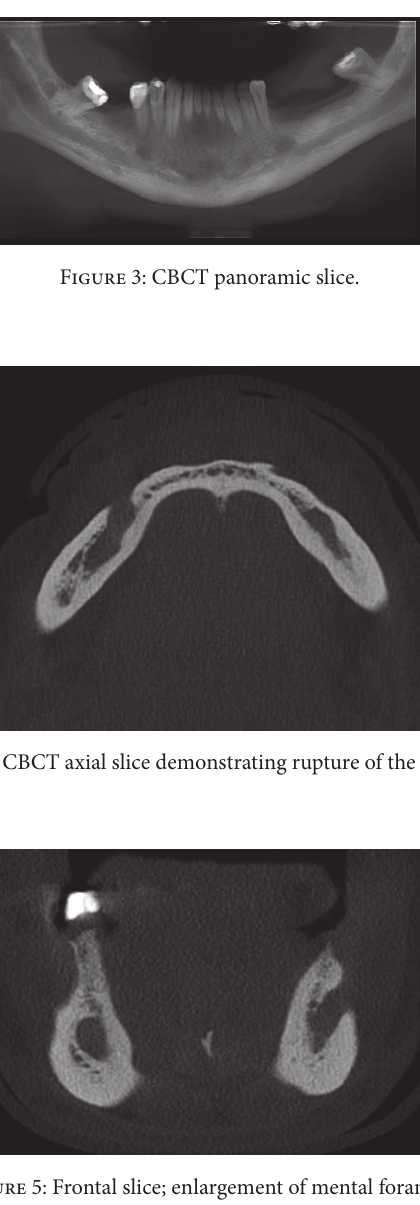
Figure 5: Frontal slice; enlargement of mental